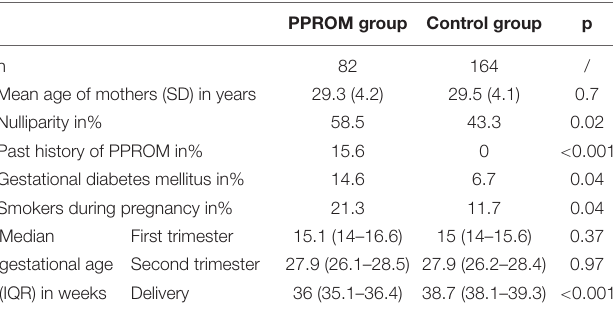
TABLE 1 | Characteristics of the case (PPROM) and control